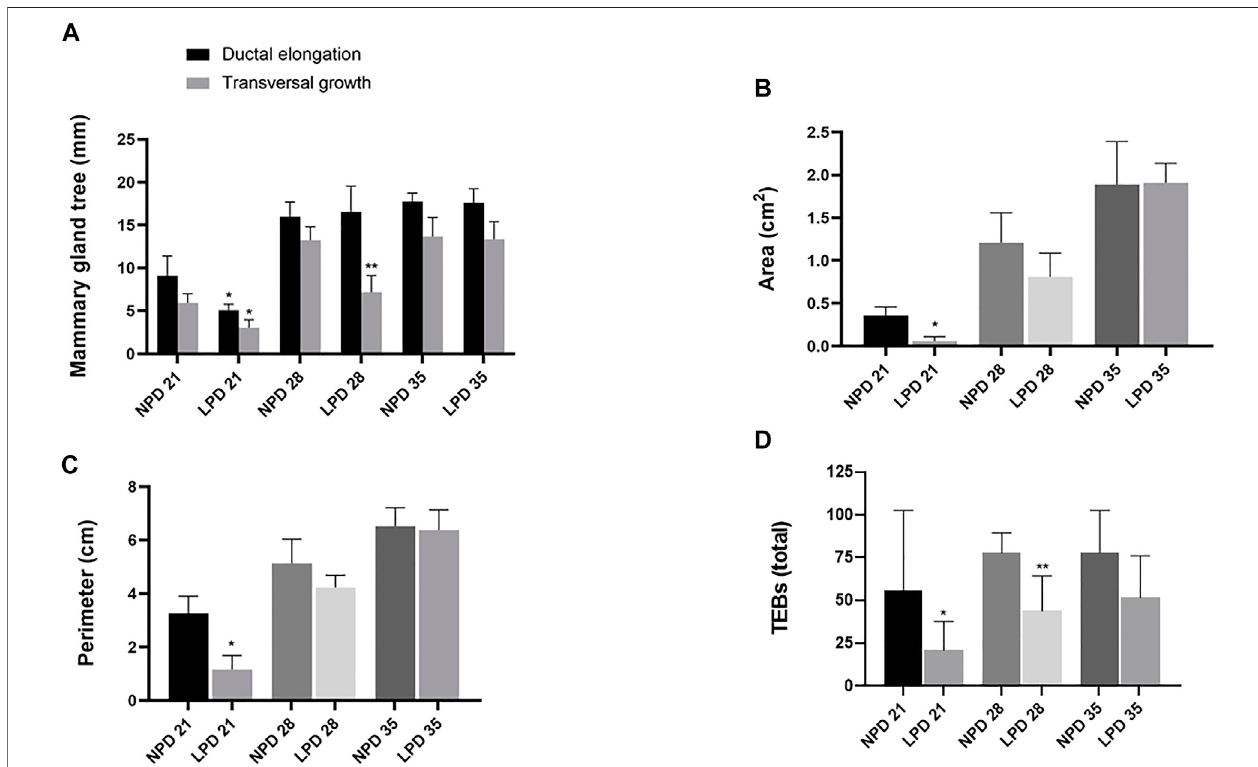
FIGURE 1 | Maternal low-protein diet programs mammary gland development of female offspring rats. Mammary gland measurements: (A) Ductal elongation and transversal growth (mm). (B) Area (cm 2 ). (C) Perimeter (cm). (D) The number of terminal end buds (TEBs) per fi eld in the external margin of the mammary gland. Values expressed as mean ± standard deviation. *,**Signi fi cant different from NPD 21 and NPD 28, respectively. The differences were determined by Student t test (0.001 ≤ p ≤ 0.049). NPD: normoprotein diet. LPD, low-protein diet. Postnatal day of euthanasia (21) and Postnatal day of MNU administration (28 or 35). MNU, N -methyl- N -nitrosourea administration (25 mg/kg, i.p.; single